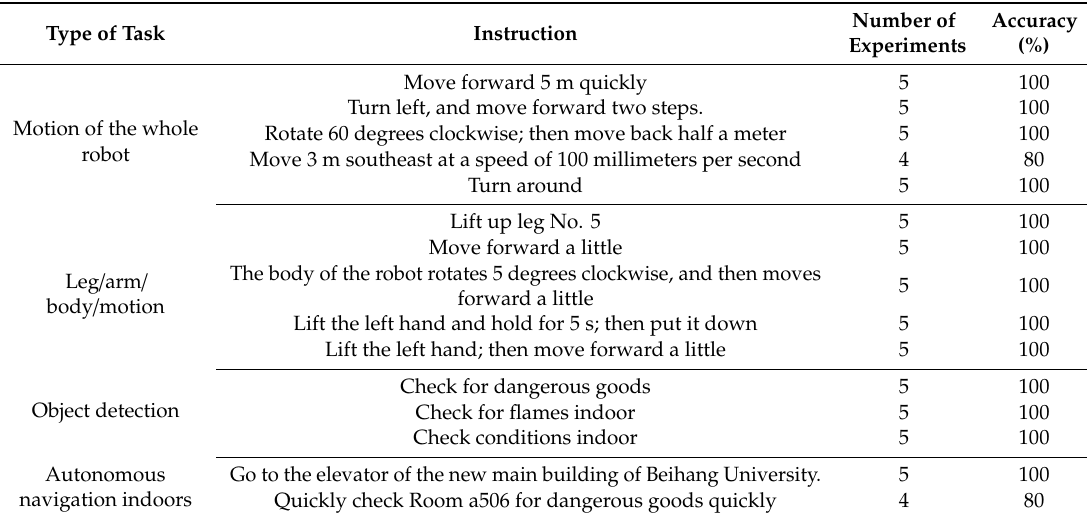
Table 11. Results of speech control.